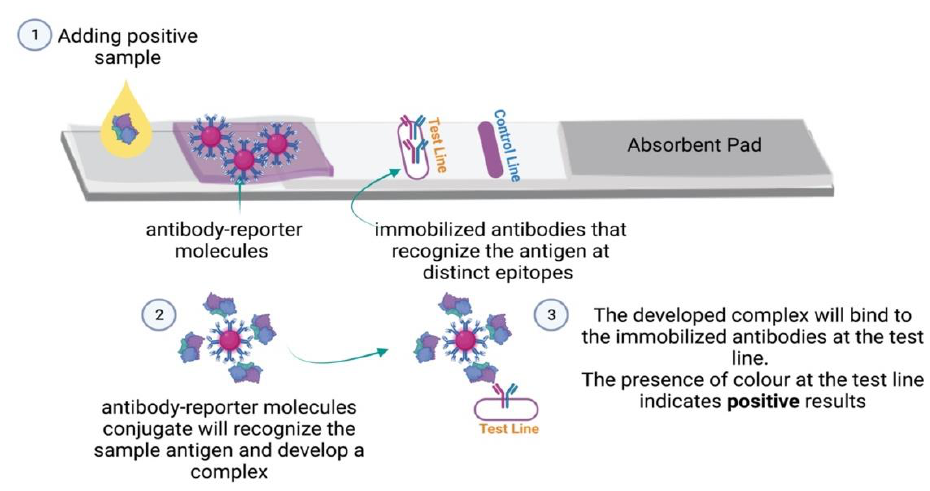
Figure 4. LFIA sandwich format: Schematic of the competitive format LFIA components and principles.